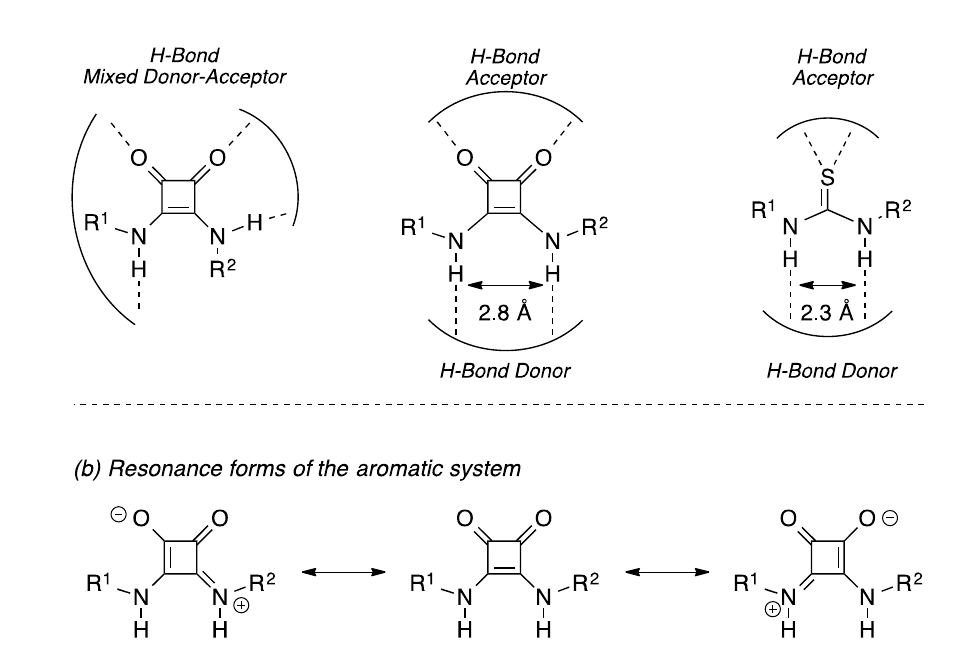
Figure 5. ( a ) H-Bond donor ability of squaramide and thiourea; ( b ) Lone pairs conjugation and resonance forms of the aromatic system.